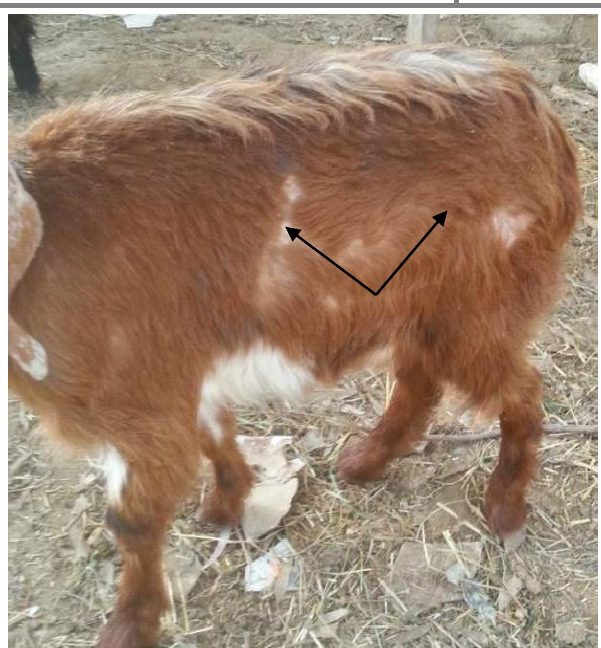
Figure 2. Goat on the 10 th week (end of the study) with rough and hair loss and emaciation